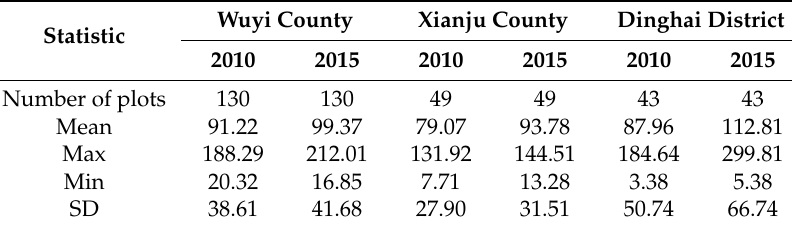
Table 1. Statistics of fi eld-based aboveground biomass (Mg/ha).